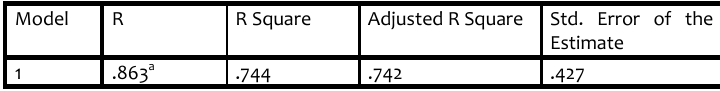
Table 5: Model Summary for Pedagogical Readiness Model